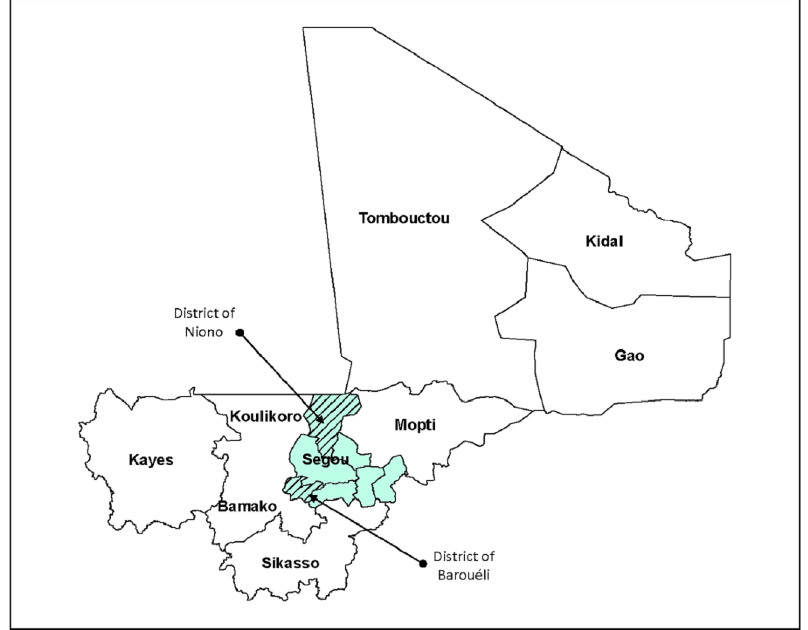
Fig 1. Map of Mali showing the two health districts selected for the RMM study in Ségou